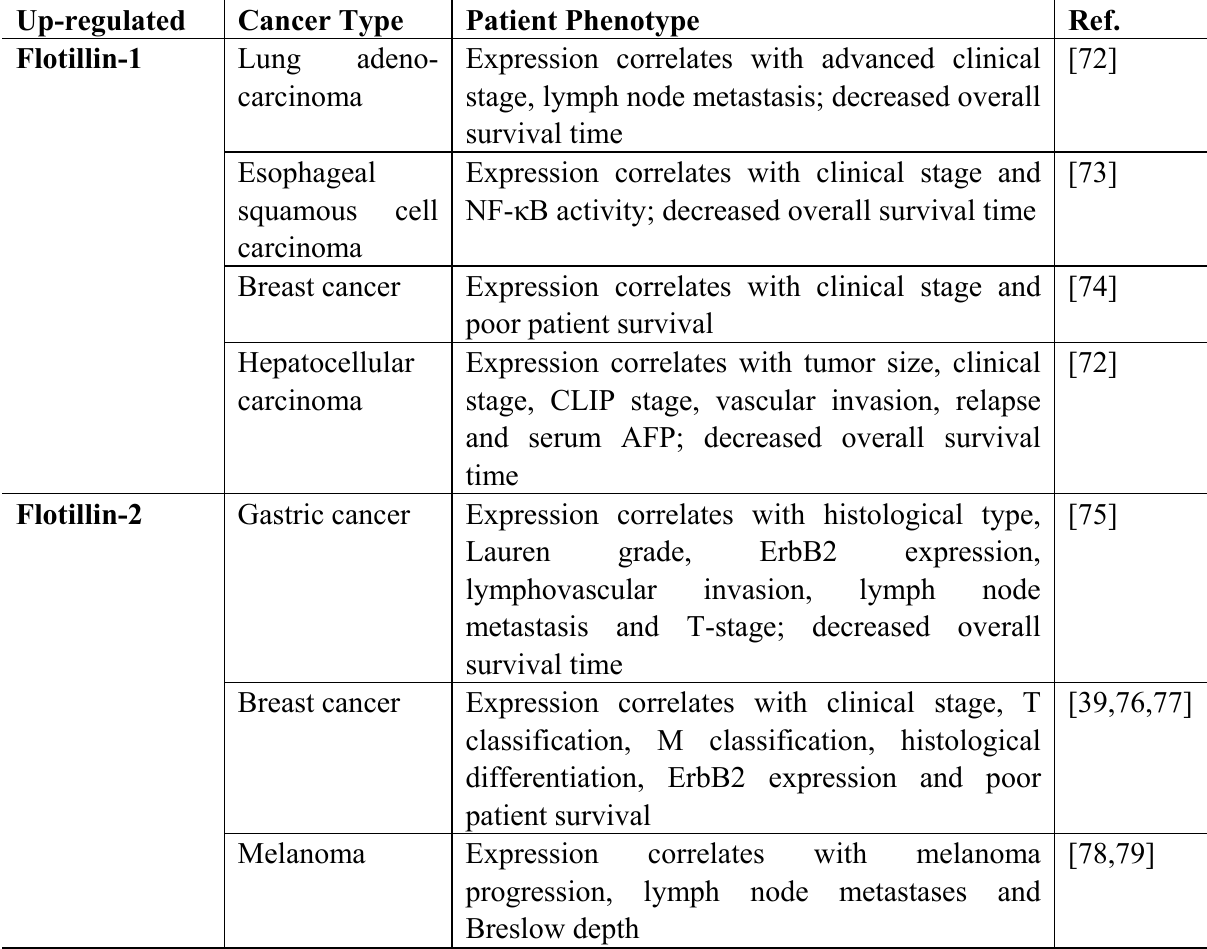
Table 1. Changes in flotillin expression in human